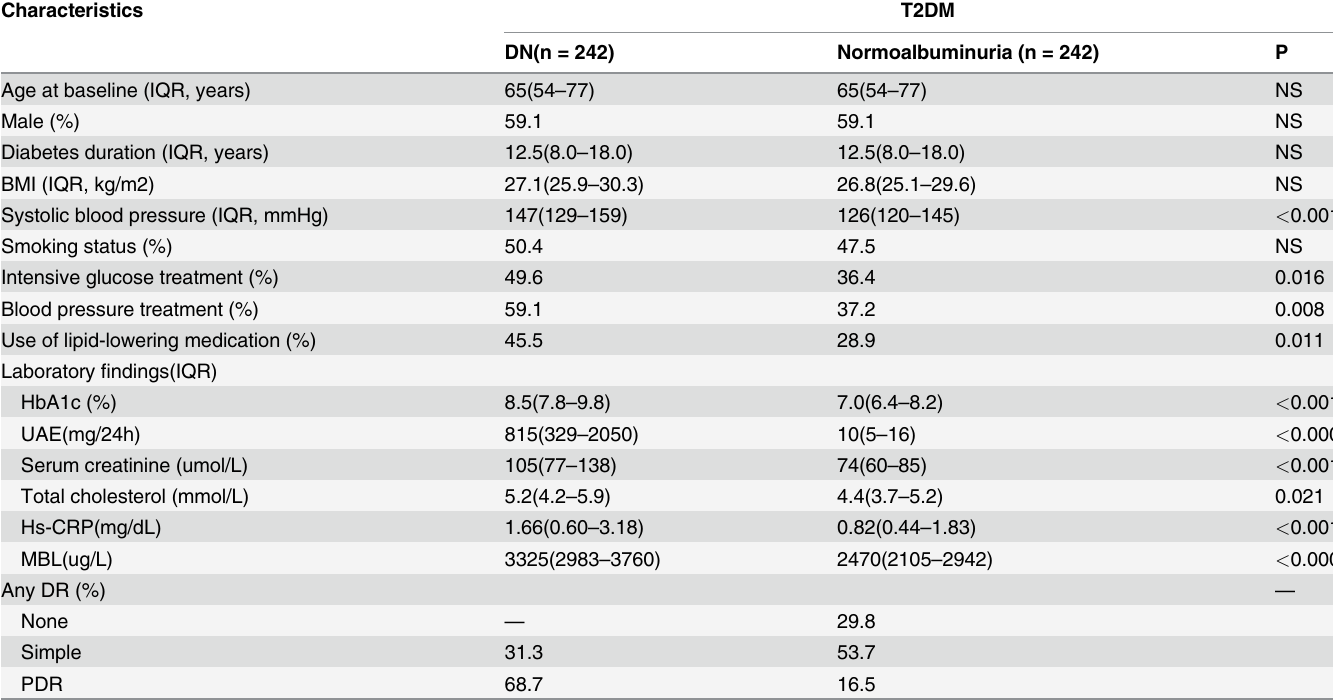
Table 1. Basal characteristic of diabetes patients with DN or